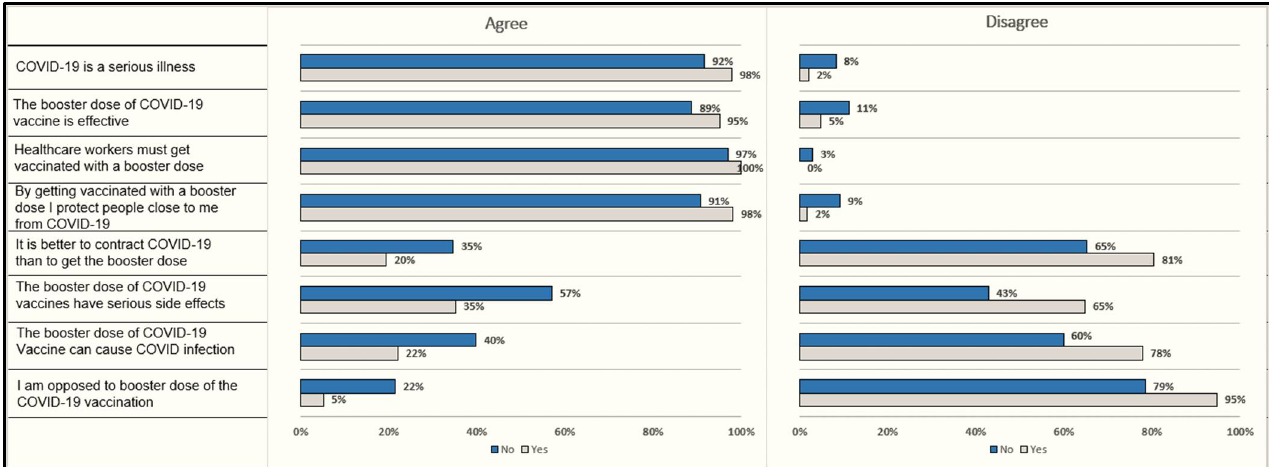
Figure 1. Item-wise comparison of vaccine confidence index among groups willing to take (yes) booster dose vs. those not willing to take (no) booster dose. Note: All differences were statistically significant at p < 0.05. Table 1. Demographic characteristics of the respondents ( n = 687).